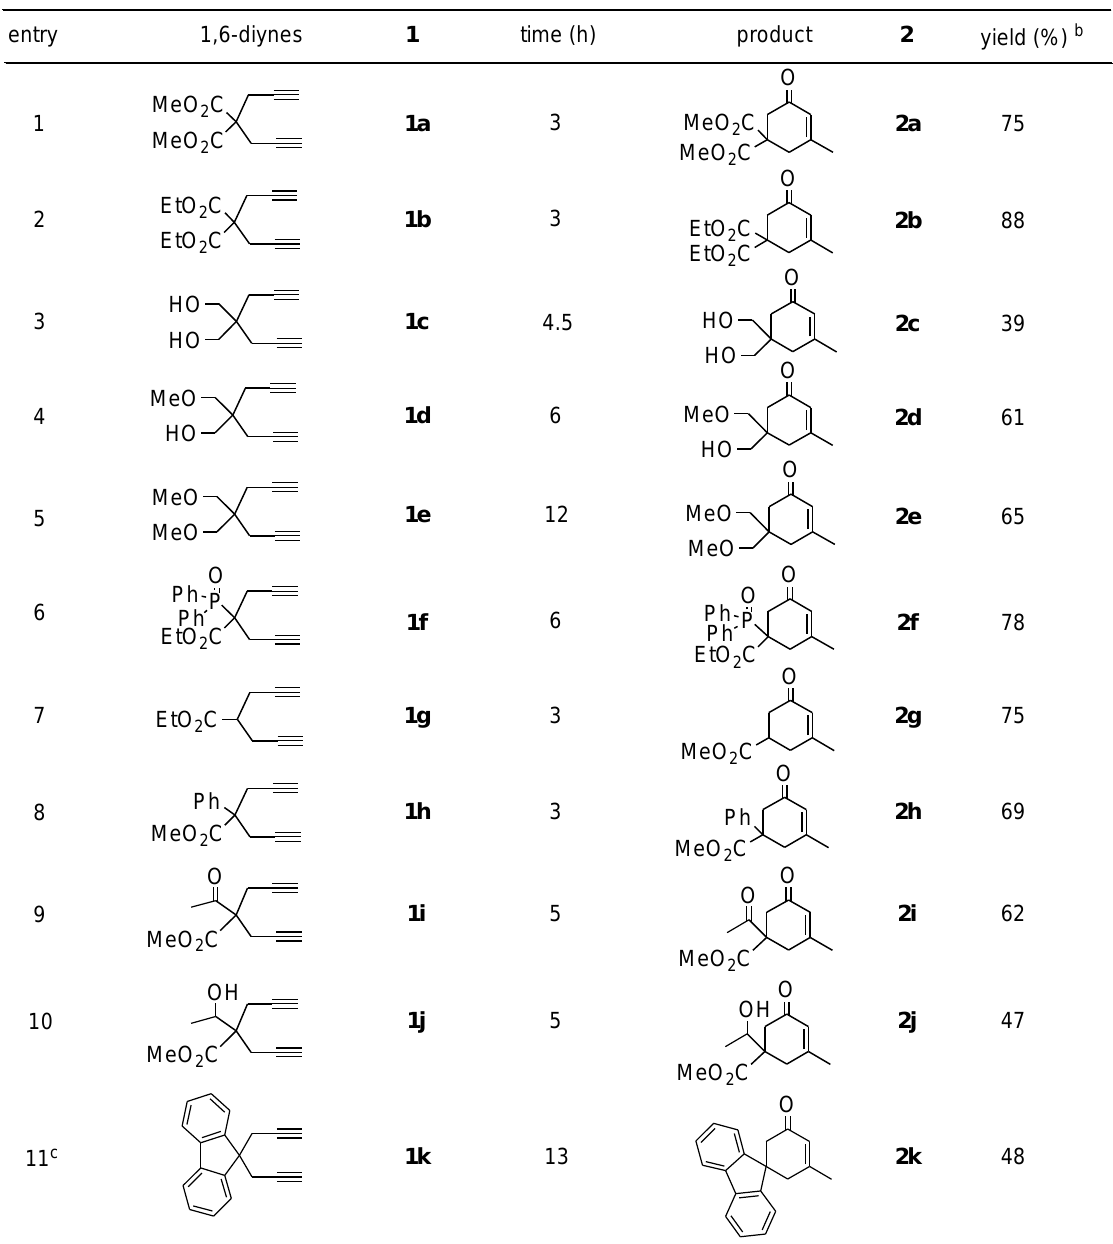
Table 2. Pt (II) catalyze hydrative cyclyzation reaction of 1, 6-heptadiynes a